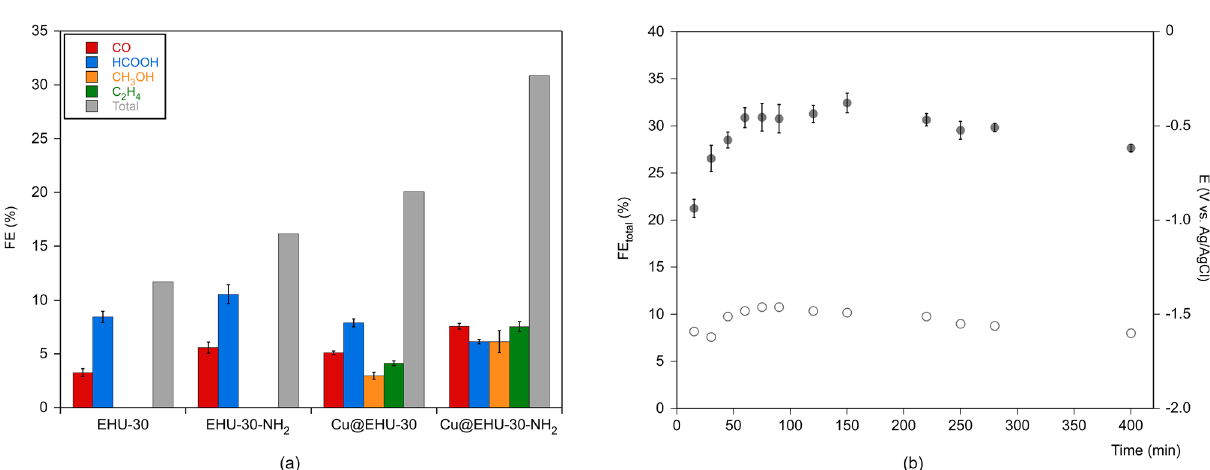
Figure 4. ( a ) FE as a function of the electrocatalytic material applied. ( b ) Time-dependence of total FE (filled circles) and current density/potential (empty circles) for all CO 2 reduction products using Cu@EHU-30-NH 2